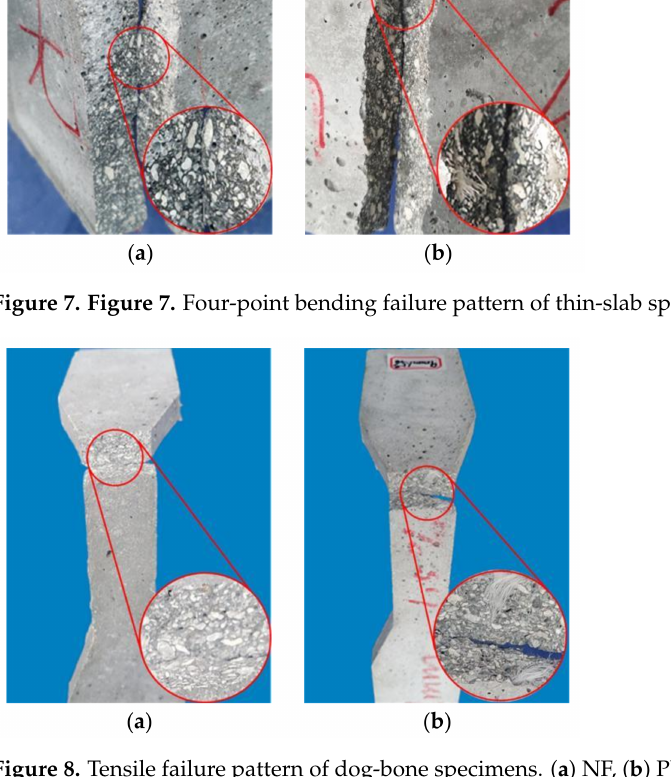
Figure 8. Tensile failure pattern of dog-bone specimens. ( a ) NF, ( b )